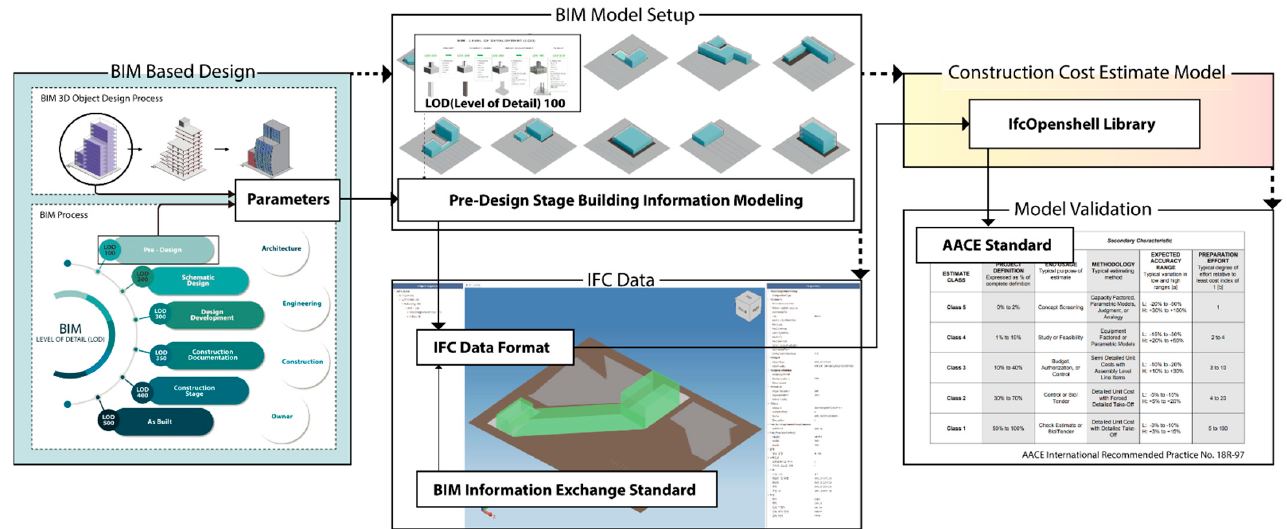
Figure 8. Construction cost estimation model validation through BIM in architectural planning